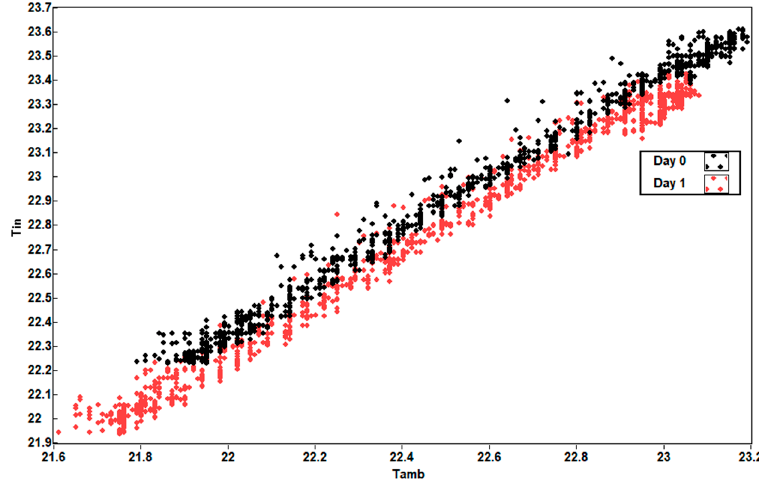
Figure 22. Scatter diagram of house battery temperature T in and installation chamber temperature T amb .